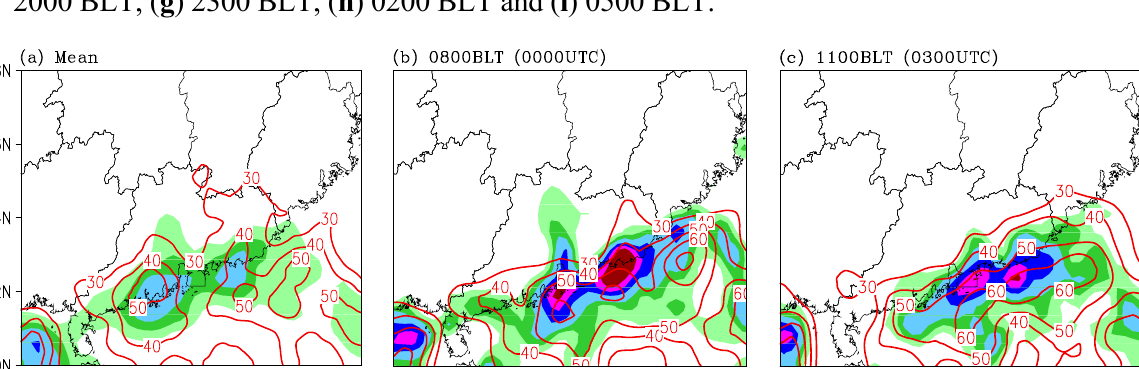
Figure 6. Mean hourly rainfall (shaded, unit: mm) and rainfall occurrence frequency (contours, unit: %) ( a ) and the diurnal evolution of rainfall intensity (shadings, unit: mm·h –1 ) and rainfall occurrence frequency (contours, unit: %) for the 10-day event based on TRMM estimates at time of ( b ) 0800 BLT , ( c ) 1100 BLT, ( d ) 1400 BLT, ( e ) 1700 BLT, ( f ) 2000 BLT, ( g ) 2300 BLT, ( h ) 0200 BLT and ( i ) 0500